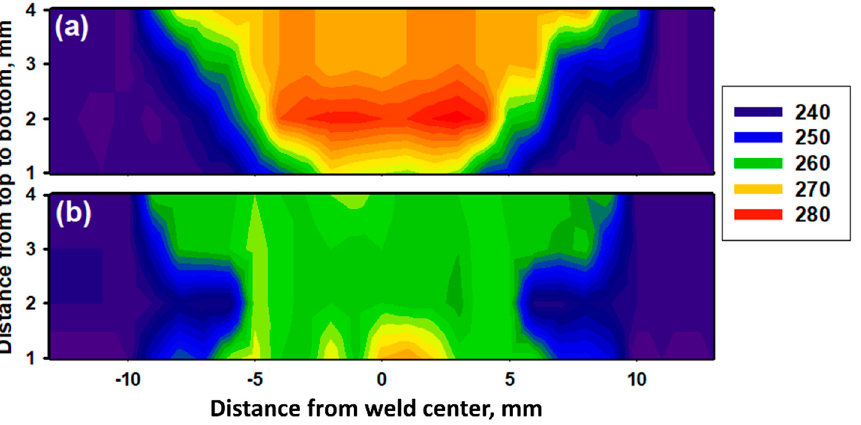
Figure 17. Vickers hardness maps of the DSS 2205 welds (a) FSWed joint produced using a 60o V groove with root face and (b) GTAWed joint. groove with root face and ( b ) GTAWed